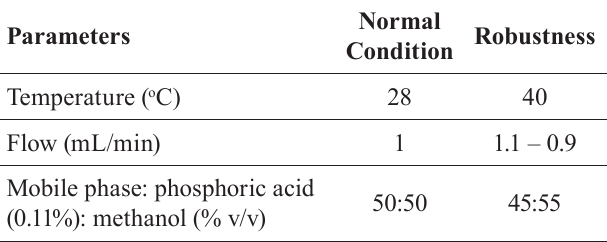
TABLE II - Variations in analytical parameters